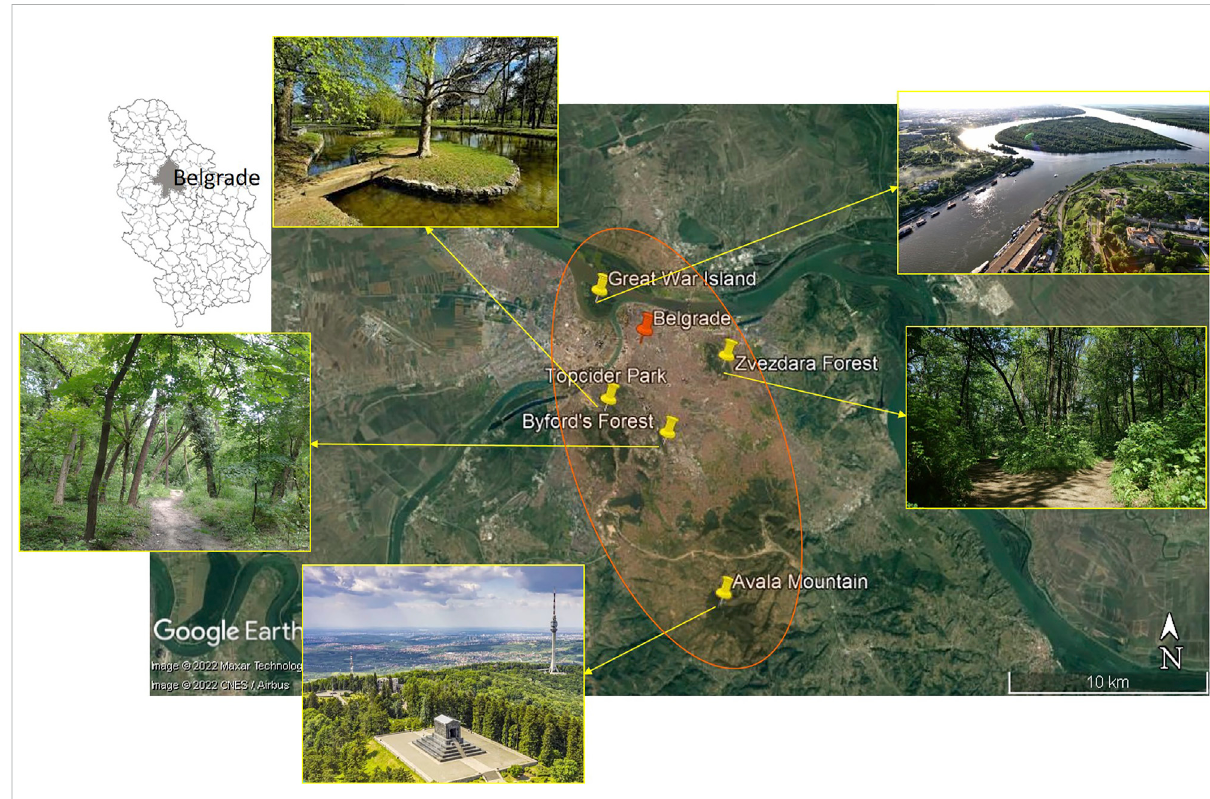
FIGURE 1 Map of Belgrade, Serbia, showing the fi ve urban protected areas: Byford ’ s and Zvezdara forest, Avala Mountain, Topcider Park. The red cycle represents the possible future connection in the city ’ s green